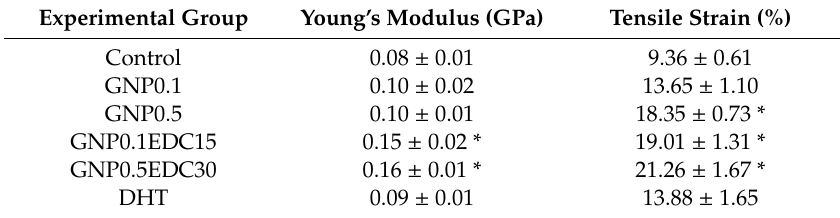
Table 1. Mechanical strength of GS was evaluated through Young’s modulus and tensile